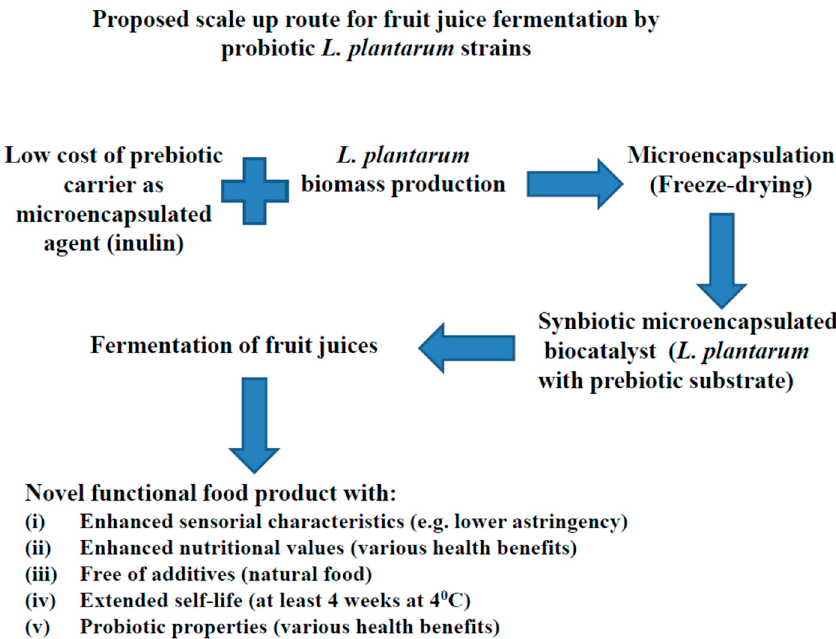
Figure 1. Proposed scale-up route for fruit juice fermentation by probiotic L. plantarum strains.